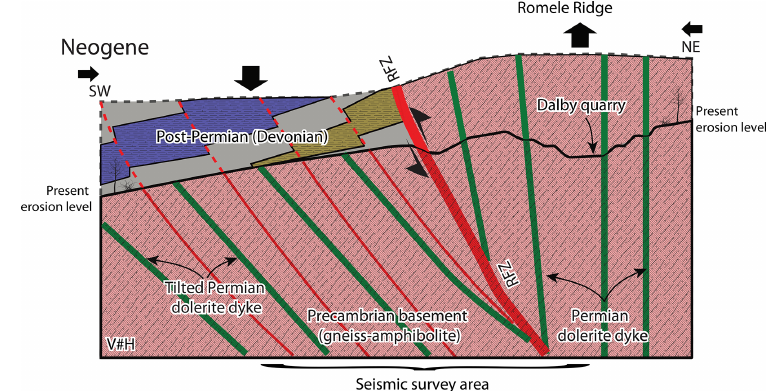
Figure 17. A simplified tectonic model (Neogene-now) illustrating our preferred scenario (see also Erlström et al., 2001) showing why the Permian dykes exhibit steeply dipping character south of the Dalby rock quarry. We associate this with a block rotation of the basement rocks immediately south of the quarry or near it (situated in the Romele Ridge) that led to the tilting of the dykes from a subvertical position to steeply dipping towards the northeast. Note that we expect some sedimentary rocks to be present south of the